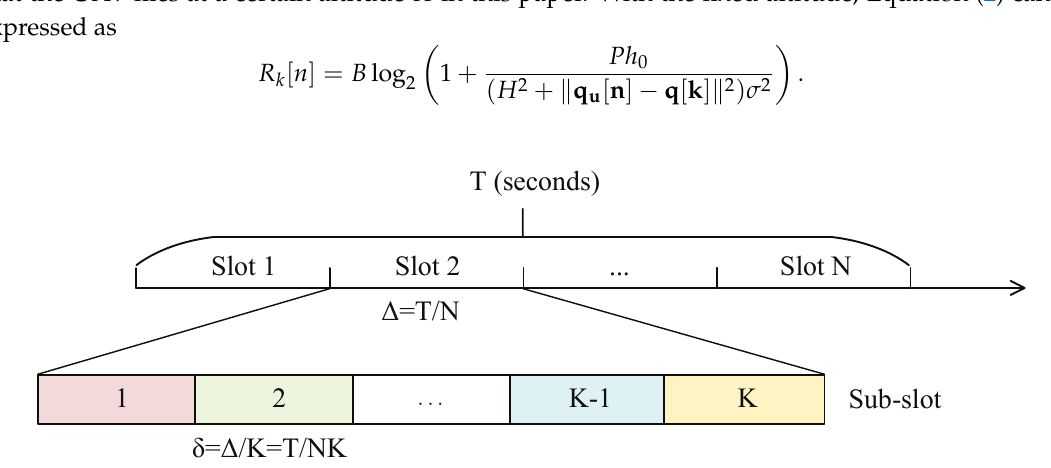
Figure 2. The slots and sub-slots